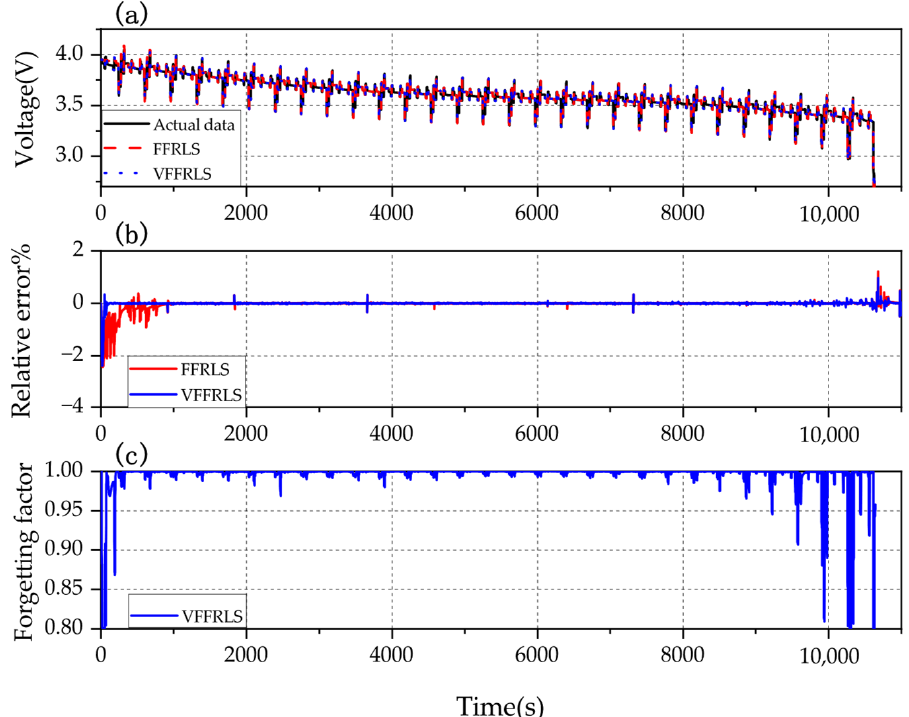
Figure 5. DST under 25 °C: ( a ) actual voltage, predictive voltage of FFRLS, and VFFRLS; ( b ) relative error of VFFRLS and FFRLS; ( c ) forgetting factor λ of VFFRLS.